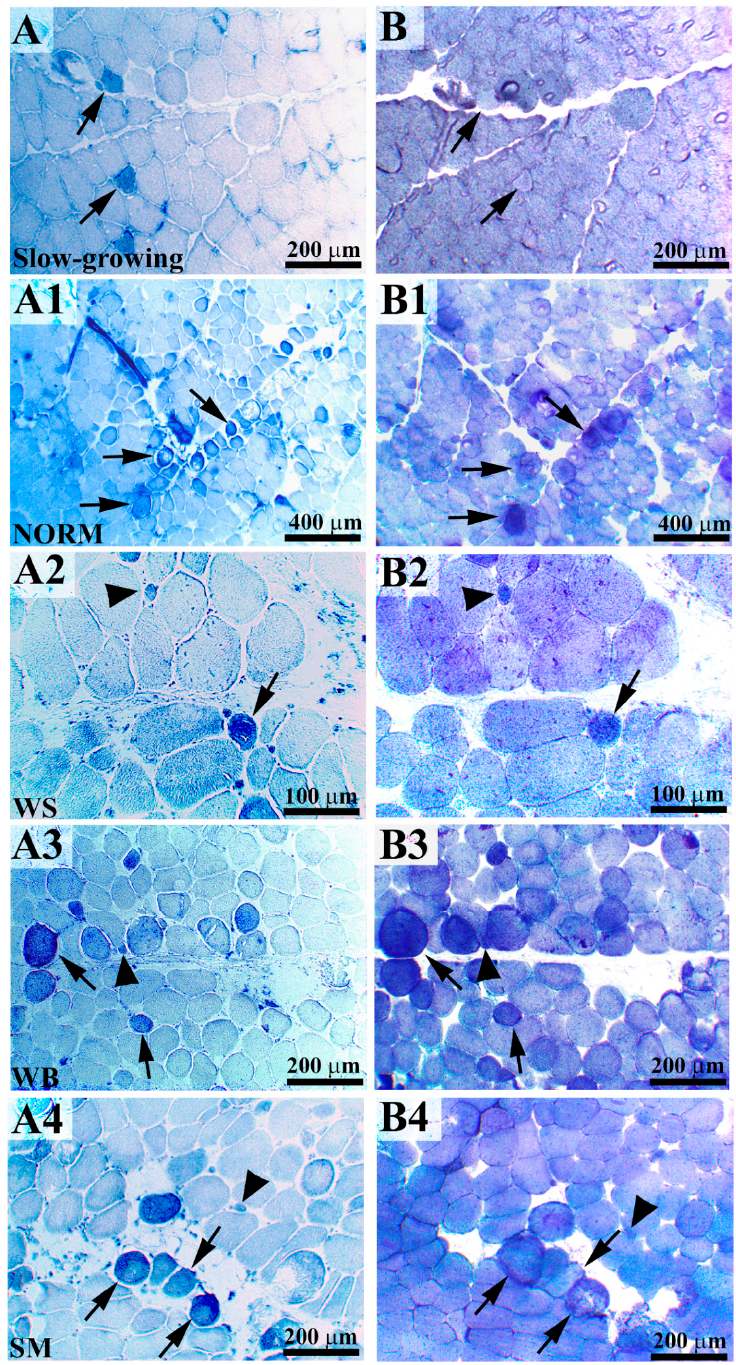
Figure 1. Serial cross-sections of pectoralis major (PM) belonging to a slow-growing genotype ( A , B ) are reported in comparison with the normal genotype (NORM) ( A 1, B 1)). Few nicotinamide adenine dinucleotide tetrazolium reductase (NADH-TR)-positive fibers were detected within the pectoralis major of the slow-growing genotype (( A ), arrows) whereas an intense and di ff use positivity for alpha-glycerophosphate dehydrogenase ( α -GPD) activity was found (( B ), arrows). In NORM, some fibers exhibiting an intense oxidative and glycolytic metabolism (( A 1, B 1), arrows) were found. In white striping (WS)-, wooden breast (WB)-, and spaghetti meat (SM)-a ff ected muscles, many fibers exhibited an intense reaction to NADH-TR (( A 2– A 4), arrows) and α -GPD (( B 2– B 4), arrows). Within these muscles, we observed intensely stained, positive small-caliber regenerative fibers in correspondence with larger-caliber fibers (( A 2– A 4, B 2– B 4),